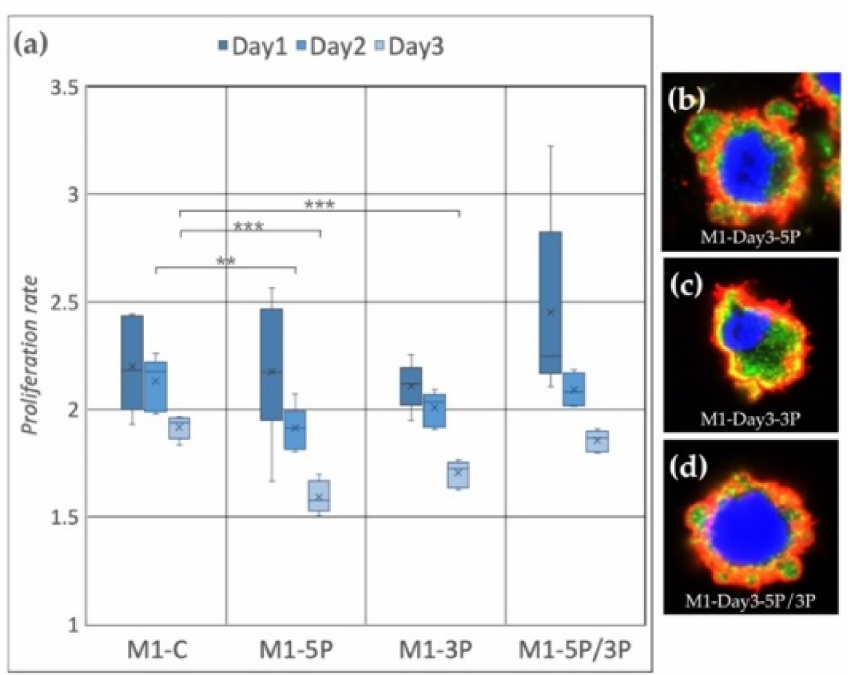
Figure 4. ( a ) Proliferation rate of M1 (ZZ genotype) PGC line on Day 1, Day 2 and Day 3. M1-C: non-inhibited, M1-5P: gga-miR-302b-5P inhibition, M1-3P: gga-miR-302b-3P inhibition, M1-5P/3P: gga-miR-302b-5P and gga-miR-302b-3P inhibition. ( b – d ) Immunostaining of M1 PGCs after three days of cultivation in different culture conditions. The immunostaining was achieved with SSEA-1 (red), CVH (green) and TO-PRO™-3 for nuclear staining (blue) ( p < 0.01 **, p < 0.001 ***). Cell line M2 (ZZ genotype) (Figure 5a) showed a significant proliferation rate